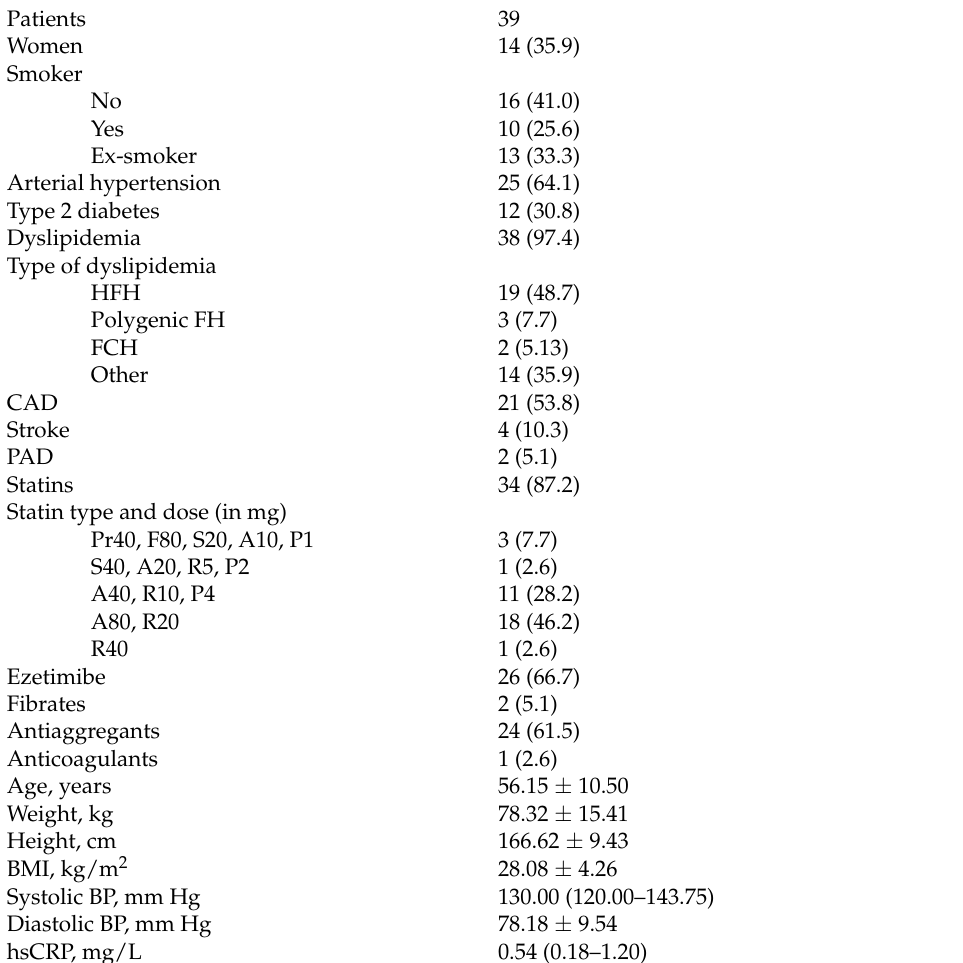
Table 1. Characteristics of the study